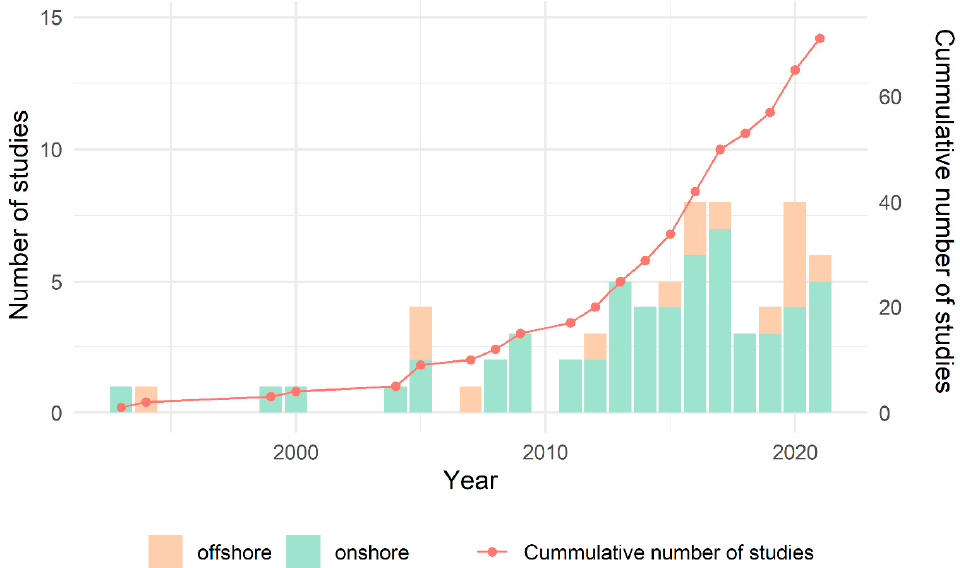
Figure 1. Number of studies per publication year focusing on bird displacement by wind turbines, for offshore and onshore wind farms. Data for 2021 are incomplete, as the bibliographic research was conducted in July 2021.